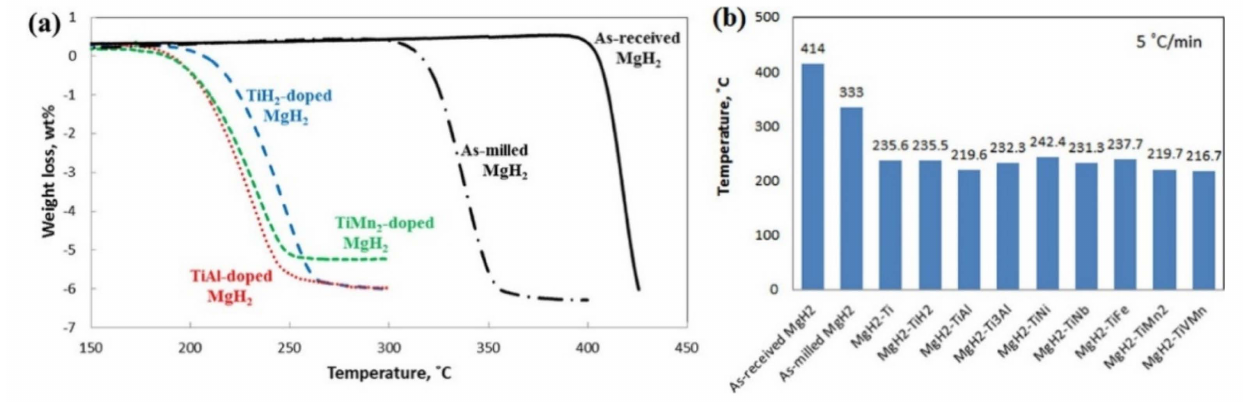
Figure 16. ( a ) TGA curves of as-received, as-milled, TiH 2 -doped, TiMn 2 -doped and TiAl-doped MgH 2 systems. ( b ) Dehydrogenation temperatures of different Ti-based catalyst-doped systems, determined by TGA profiles at fractional conversion α = 0.4 [134]. (Reprinted with permission from the American Chemical